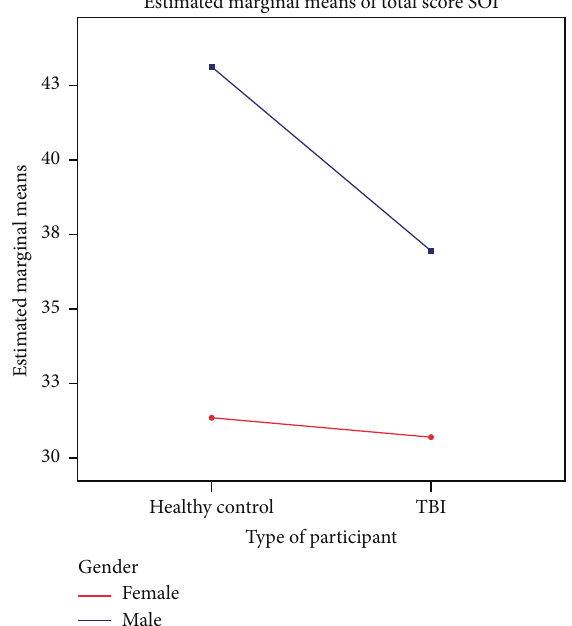
Figure 1: Estimated marginal means for sociosexuality as a function of group and gender. Abbreviation: SOI, total score of the Sociosex- ual Orientation